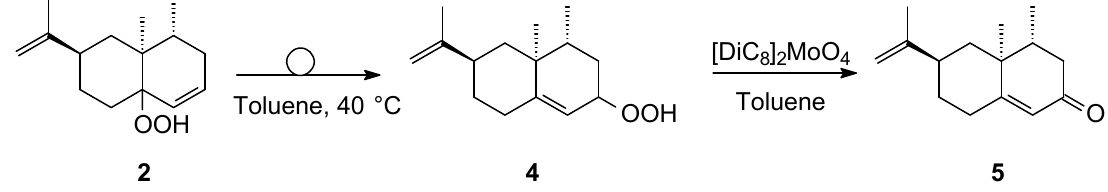
Figure 3. Schenck rearrangement of hydroperoxide 2 into hydroperoxide 4 followed by conversion of hydroperoxide 4 into nootkatone 5 catalyzed by molybdate ions in toluene.